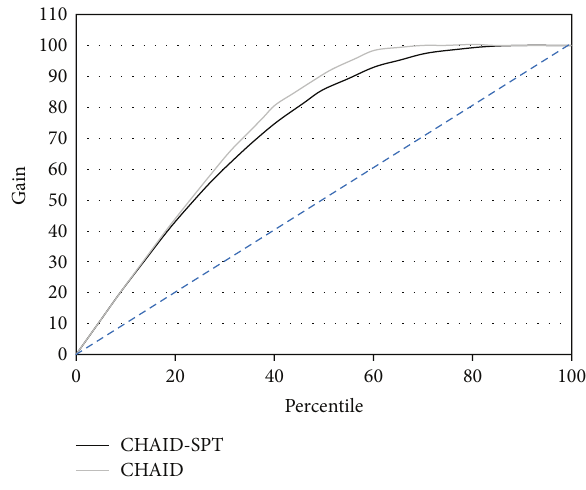
Figure 2: Gain plot of the CHAID and CHAID-SPT